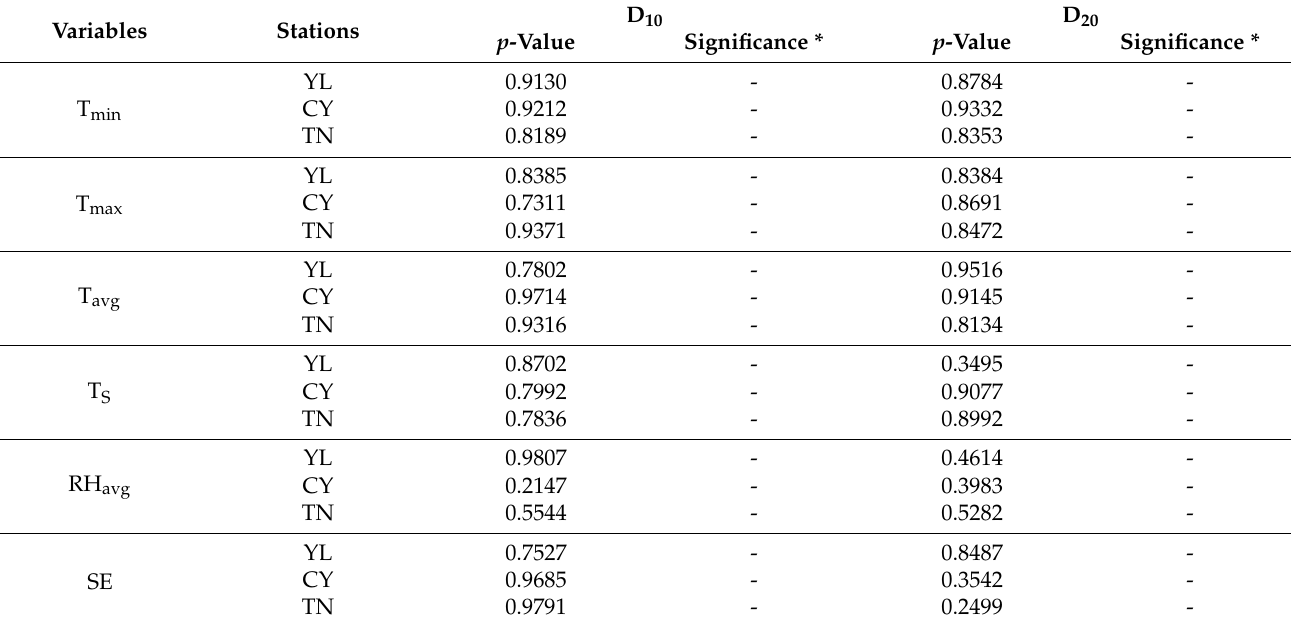
Table 4. Dataset differences significance test by independent sample t